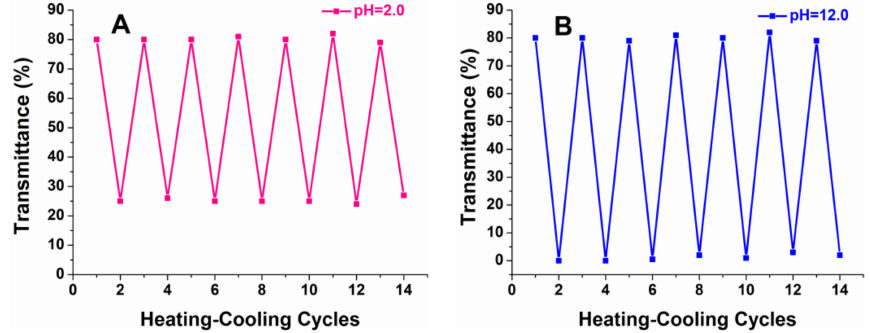
Figure 11. Transmittance change during the heating-cooling cycles of PNIPAM-PLL-AuNPs between 25 ◦ C and 50 ◦ C under pH = 2.0 ( A ) and pH = 12.0 ( B ). (Concentration: 2.0